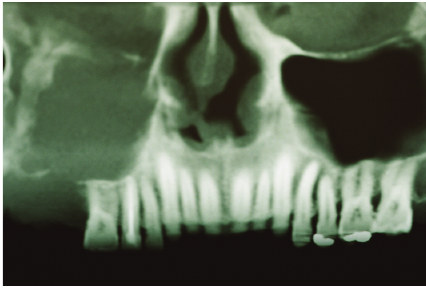
Figure 1: Cone beam computed tomography scan showing a sinonasal mass causing opacification of the right maxillary sinus with erosion of the orbital floor, lateral nasal wall, and maxillary sinus floor.